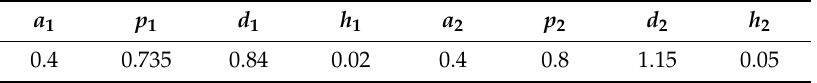
Figure 2. Dispersion diagram of electromagnetic band gap (EBG) unit #1 and #2. Table 1. Dimension of the EBG units (unit: millimeter).